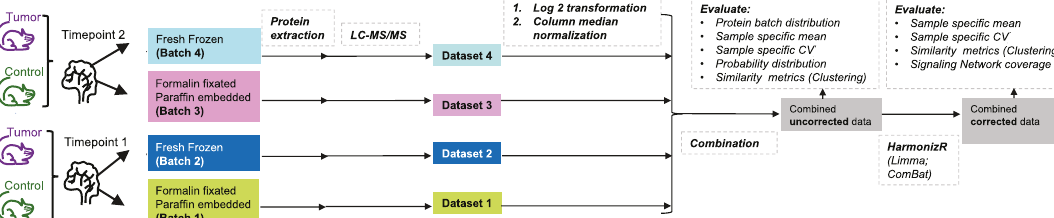
Missing value tolerant, “ Nonlinear Iterative vertical Least Squares (NIPALS) ” PCA 21 was carried out to compare dataset variances before normalization, after iRS and after ComBat HarmonizR considering multiple dimensions. Prior to batch effect reduction, samples clustered in dependence of their